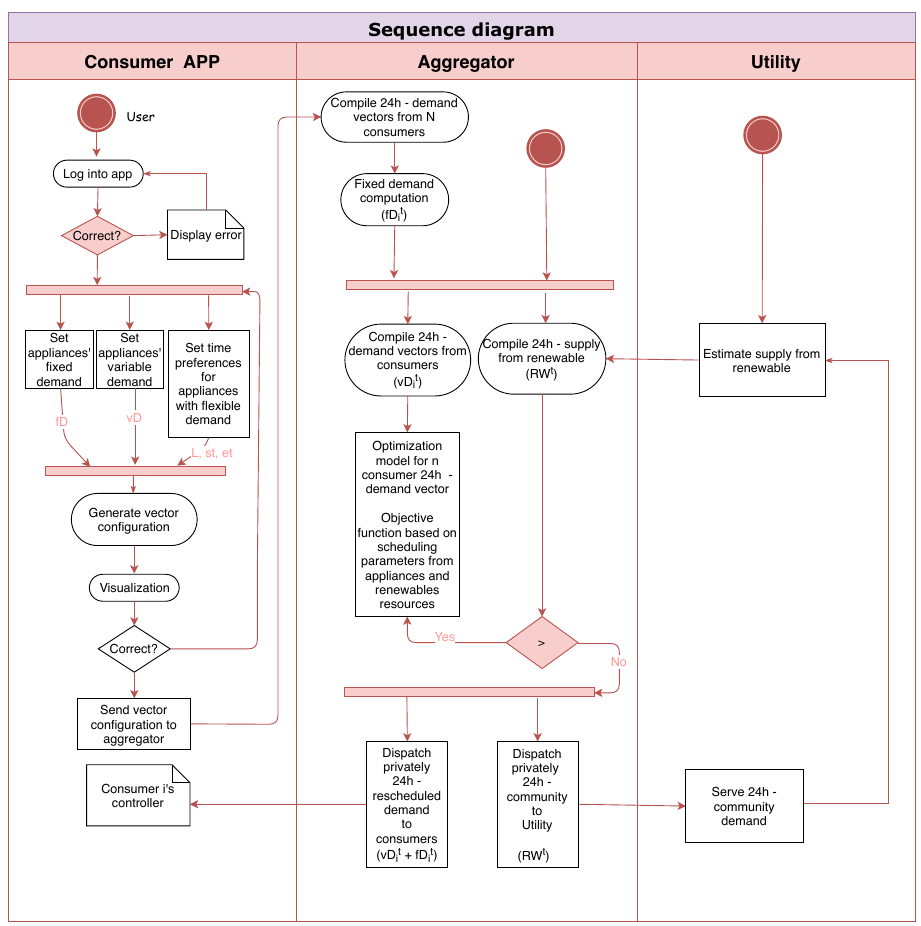
Figure 4. Sequence stating main processes and message exchange among the system’s